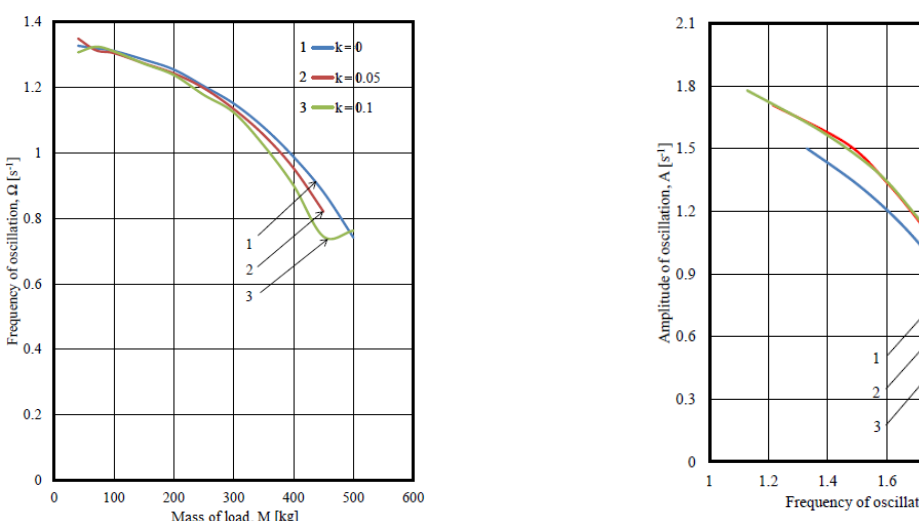
Figure 24. Dependence of the frequency of oscillations of angular velocity on load mass in different values of coefficient of rotational friction and coefficient of sliding friction f = 0.